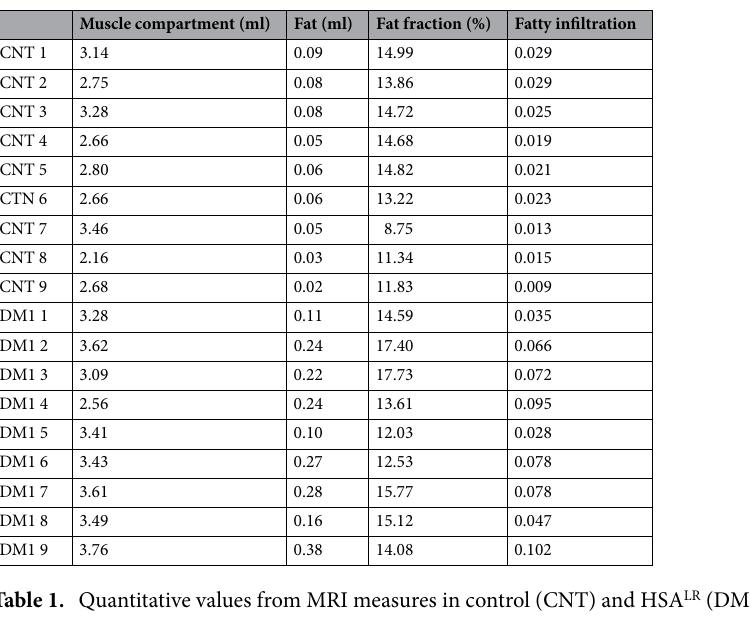
Table 1. Quantitative values from MRI measures in control (CNT) and HSA LR (DM1) mice.